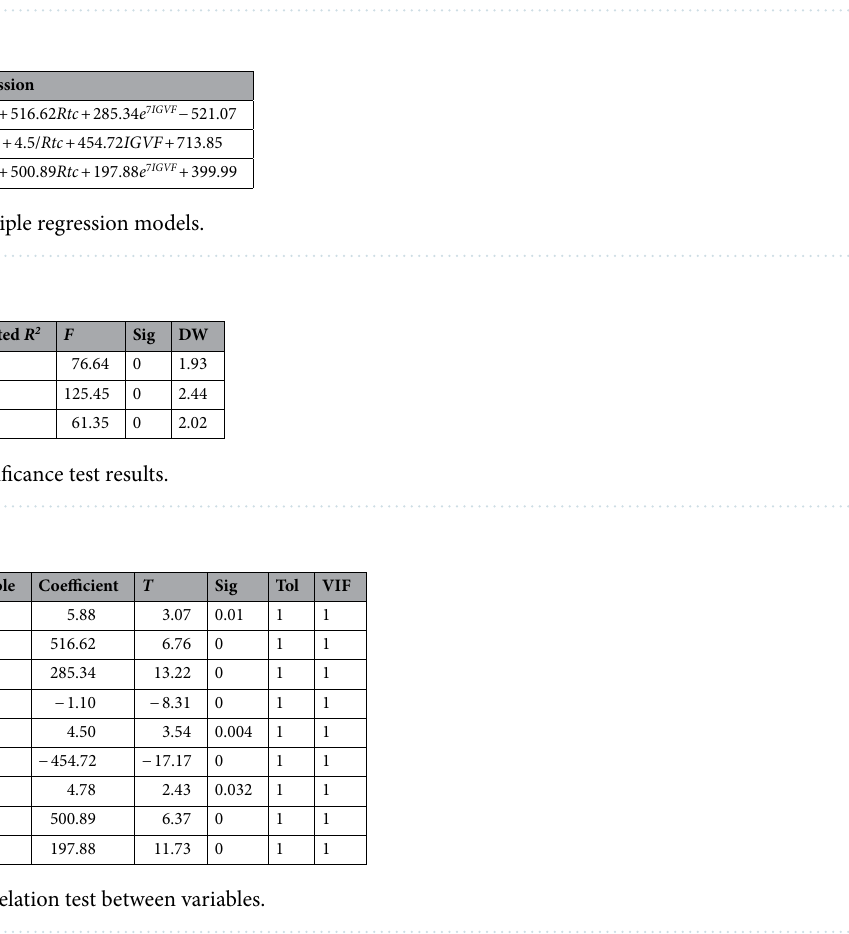
Table 6. Influence of multiple variables on enstrophy dissipation power.